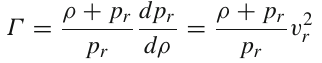
Fig. 30 RadialvariationofdifferentforcesinsideEXO1745-248.Here red,green,blueandblacklinesrepresentgravitationalforce( F g ),hydro- static force ( F h ), anisotropic force ( F a ) and electrostatic force ( F e ) respectively. Solid, dashed and dotdashed curves correspond to D = 4, D = 5 and D = 6 respectively